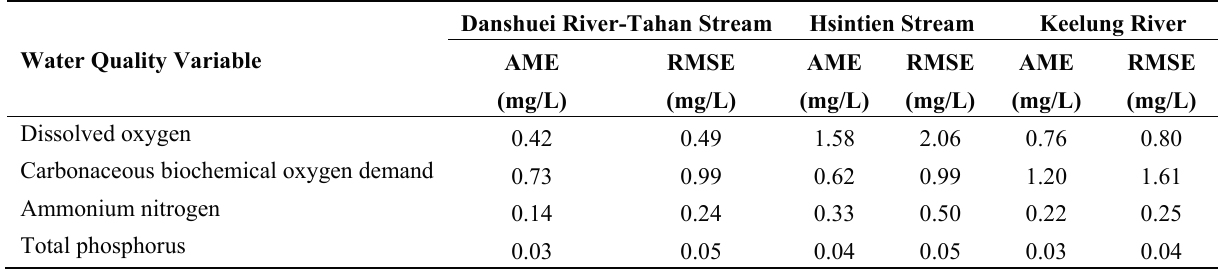
Table 4. Statistical error between simulated and measured water quality variables on 1 June 2010.